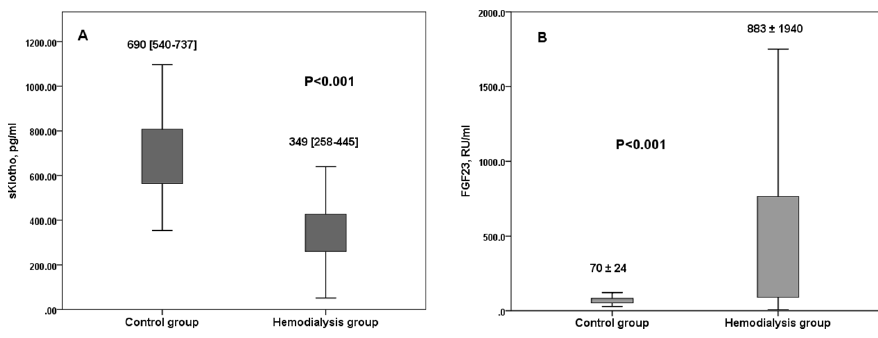
Figure 4. Klotho (A) and FGF23 (B) levels in controls versus hemodialysis patients. File S1 Tables S1–S4 and Figure S1. Table S1. Hazard Ratios (and 95% CIs) for Death per Standard Deviation of FGF23 and Klotho levels and according to the level tertiles. FGF23 and Klotho levels two weeks after enrolment. Table S2. Baseline characteristics and laboratory parameters according to presence or absence of atrial fibrillation. Table S3. Association of Klotho levels two weeks after enrolment with the presence of atrial fibrillation. Table S4. Regression analysis for Klotho tertiles two weeks after enrolment with the absence of atrial fibrillation. Figure S1. Dilution experiment for the Klotho and FGF23 assays. Eleven random samples were tested at sample: dilution ratios 1:2 and 1:4.